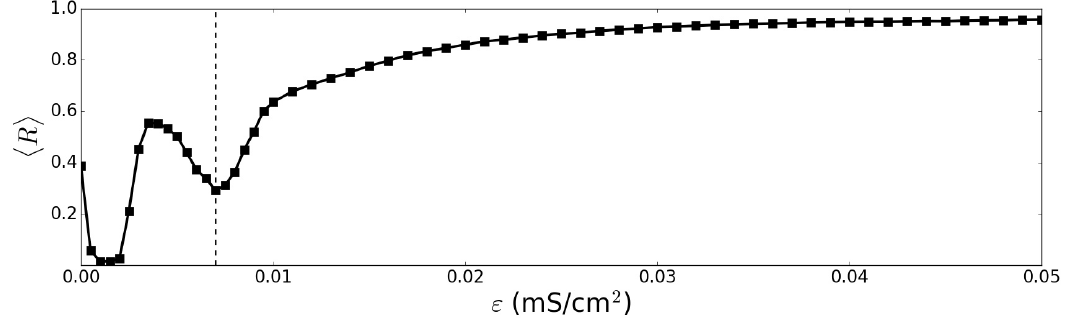
Figure 2. The mean order parameter (cid:104) R (cid:105) as a function of the coupling parameter ε for a scale-free neural network with 5000 identical neurons with randomly distributed initial conditions. The dashed vertical line represents the critical coupling ε ∗ .